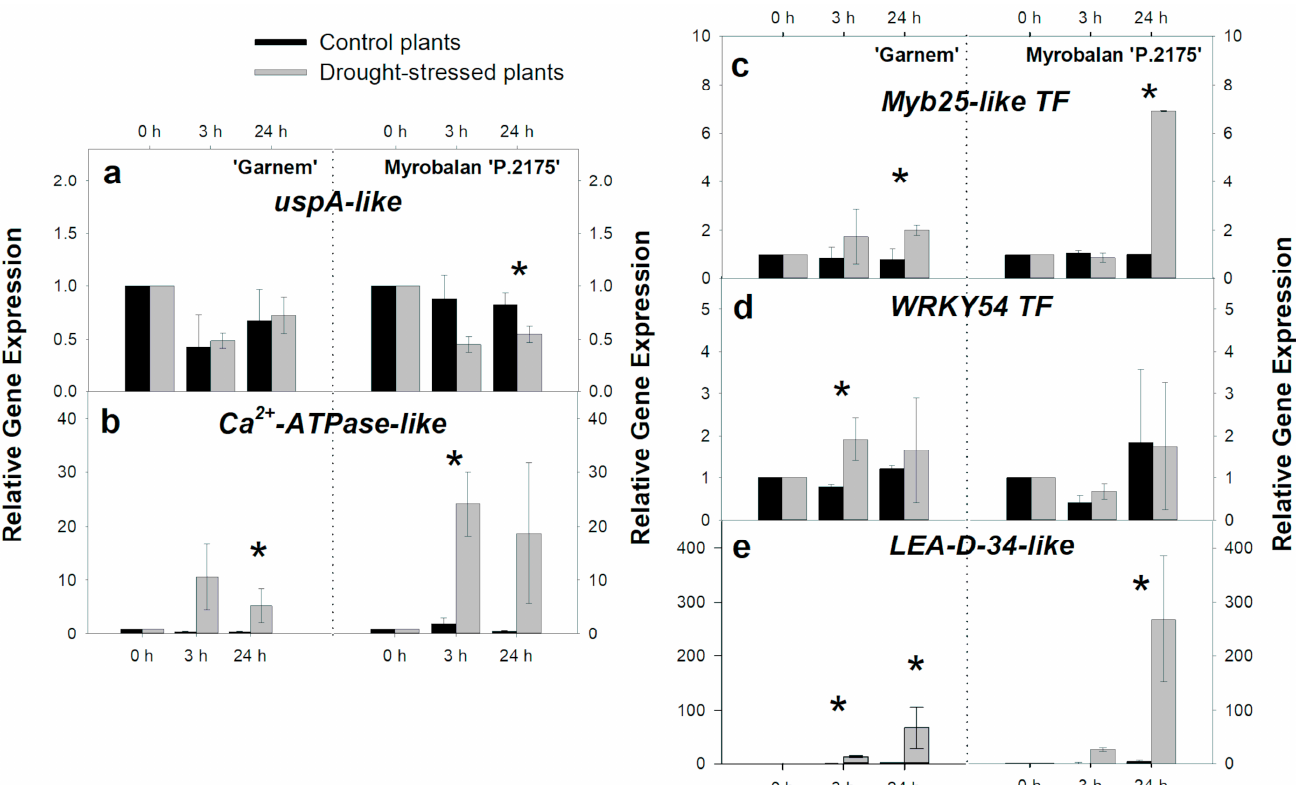
Figure 5. Relative expression of ( a ) universal stress protein A-like protein ( uspA-like ); ( b ) Ca 2+ -transporting ATPase plasma membrane-type-like ( Ca 2+ -ATPase-like ); ( c ) Myb25-like transcription factor ( Myb25-like TF ); ( d ) WRKY54 transcription factor ( WRKY54 TF ); and ( e ) late embryogenesis abundant protein D-34-like ( LEA-D-34-like ). Expression levels were compared to the TEF2 gene. The relative value of 1 was assigned to the sample on hour 0 (control time-point value). Data show the average relative expression of two biological samples with three technical replicates of each one. Error bars represent the standard error of the mean. Asterisks (*) indicate significantly different expression values ( p ≤ 0.05) following the Student’s t -test between treatments (control vs. drought stress) within each genotype (‘Garnem’ vs. Myrobalan ‘P.2175’) for each time point of the experiment (0 h–3 h–24 h).